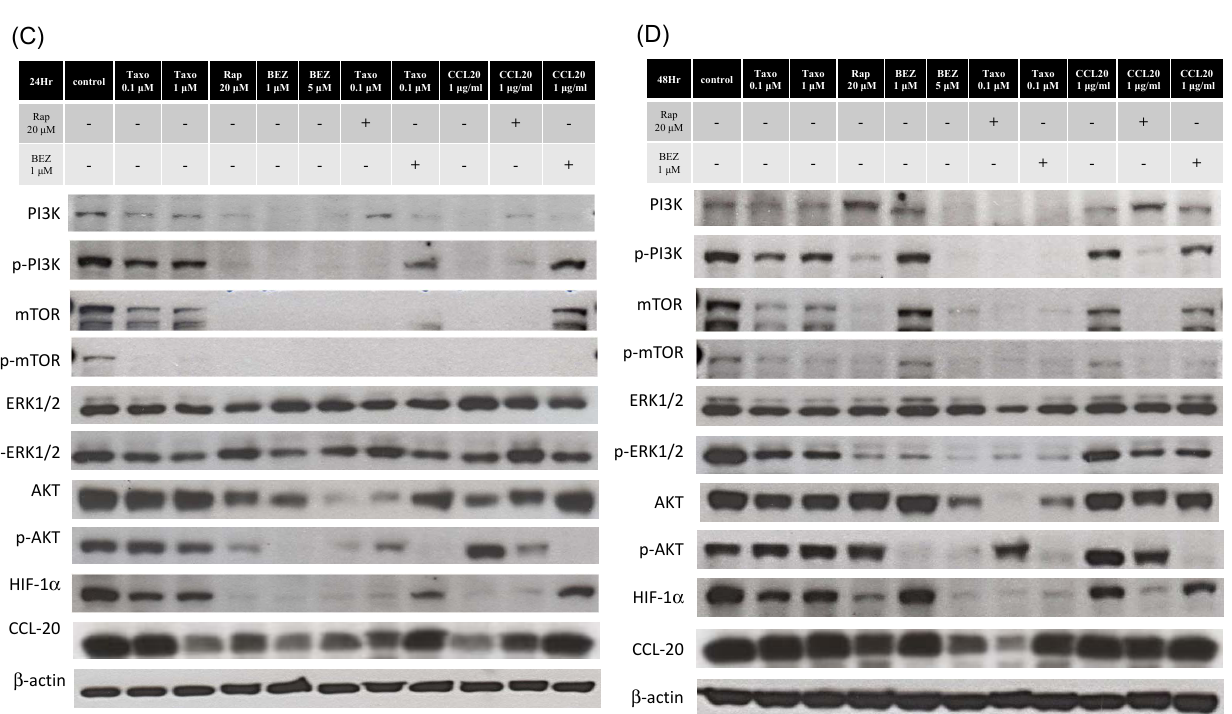
Figure 4. Effect of mTOR inhibitors (rapamycin and BEZ235) combined with docetaxel or CCL-20 on the expression of the mTOR signaling pathway proteins in HNSCC cells. Cells were treated with docetaxel (0.1 or 1 µ M), rapamycin (20 µ M), BEZ235 (1 or 5 µ M), CCL-20 (1 µ g/mL), or a combination. After 24 or 48 h, total cell lysates were prepared to perform a Western blot analysis for p-PI3K, PI3K, p-mTOR, mTOR, p-ERK1/2, ERK1/2, p-AKT S473, AKT, HIF-1 α , and CCL-20 expression. β -actin was used for loading control. ( A , B ) In the FaDu cell line, the marked reduction in mTOR signaling pathway protein levels after treatment with rapamycin or BEZ235 for 24 or 48 h was synergistic with docetaxel and restored by CCL-20 treatment. Unlike BEZ235 (a dual inhibitor of PI3K and mTOR), rapamycin (20 µ M) increased p-PI3K and p-ERK1/2 expressions at 24 h. ( C , D ) In the SAS cell line, the marked reduction in the p-PI3K, p-ERK1/2, p-AKT S473, and mTOR signaling pathway protein levels after treatment with rapamycin or BEZ235 for 24 or 48 h was synergistic with docetaxel and restored by CCL-20 treatment. The corresponding statistical analysis results for the Western blot tests